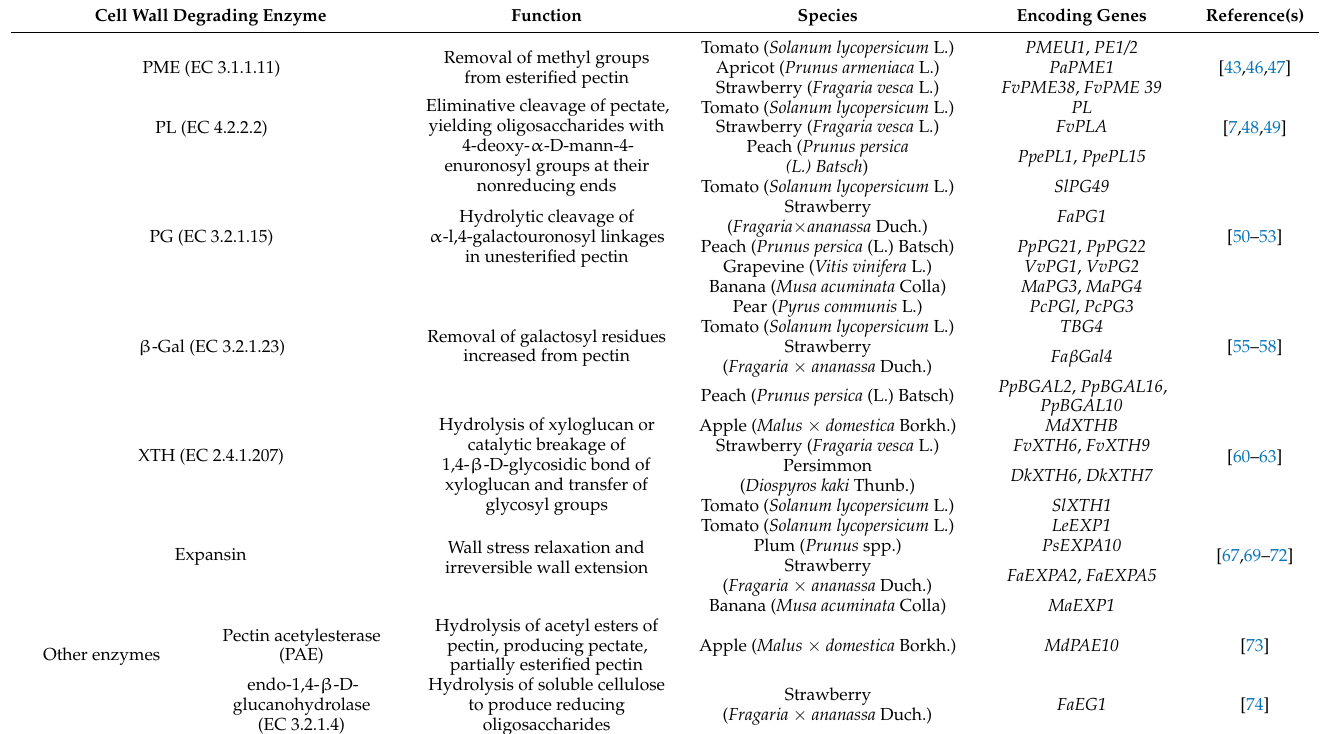
Table 1. Regulation of cell wall metabolizing enzyme-related genes on the ripening and softening of fleshy